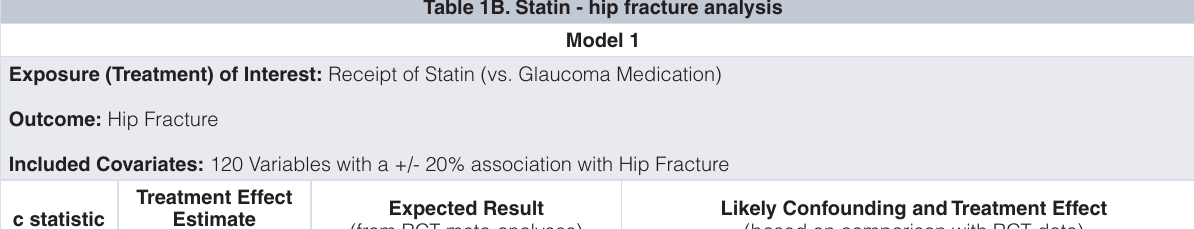
Table 1. Examples of qualitative application of the ACCE Method (drawn from Reference 10). ( continued ) Table 1B. Statin - hip fracture analysis Model